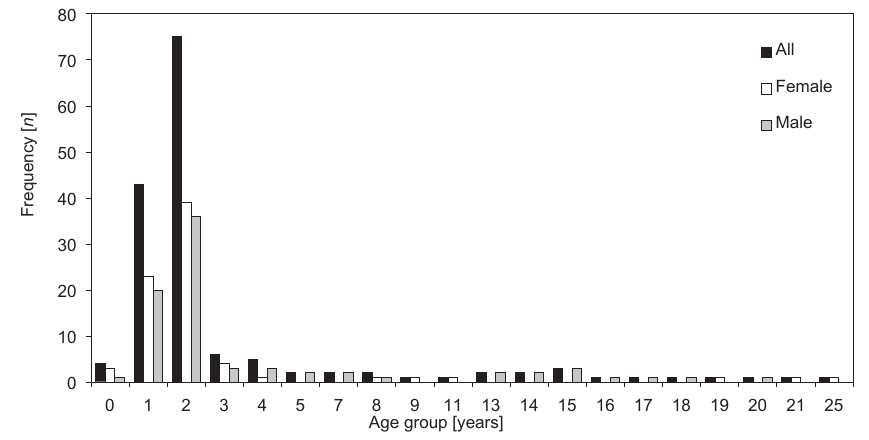
Fig. 8. Age-frequency distribution of Mustelus mustelus from the Gulf of Iskenderun, north-eastern Mediterranean